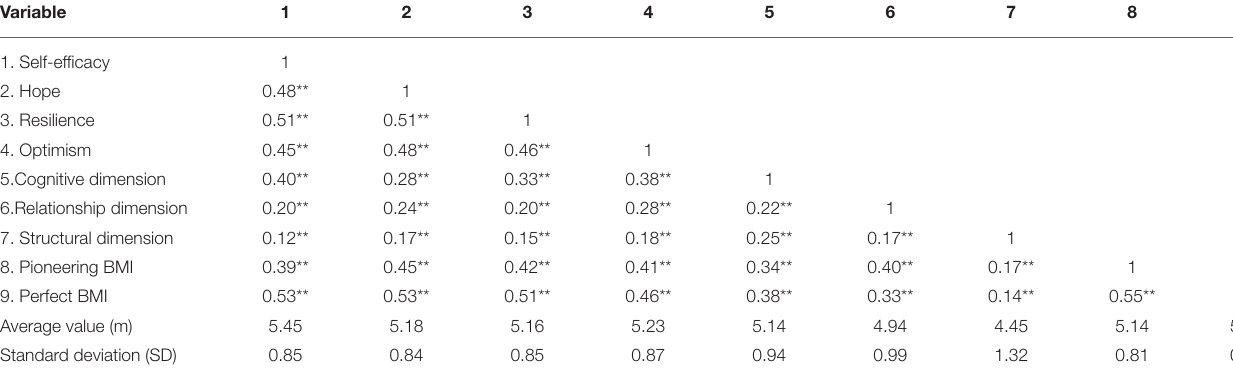
TABLE 3 | Descriptive statistical